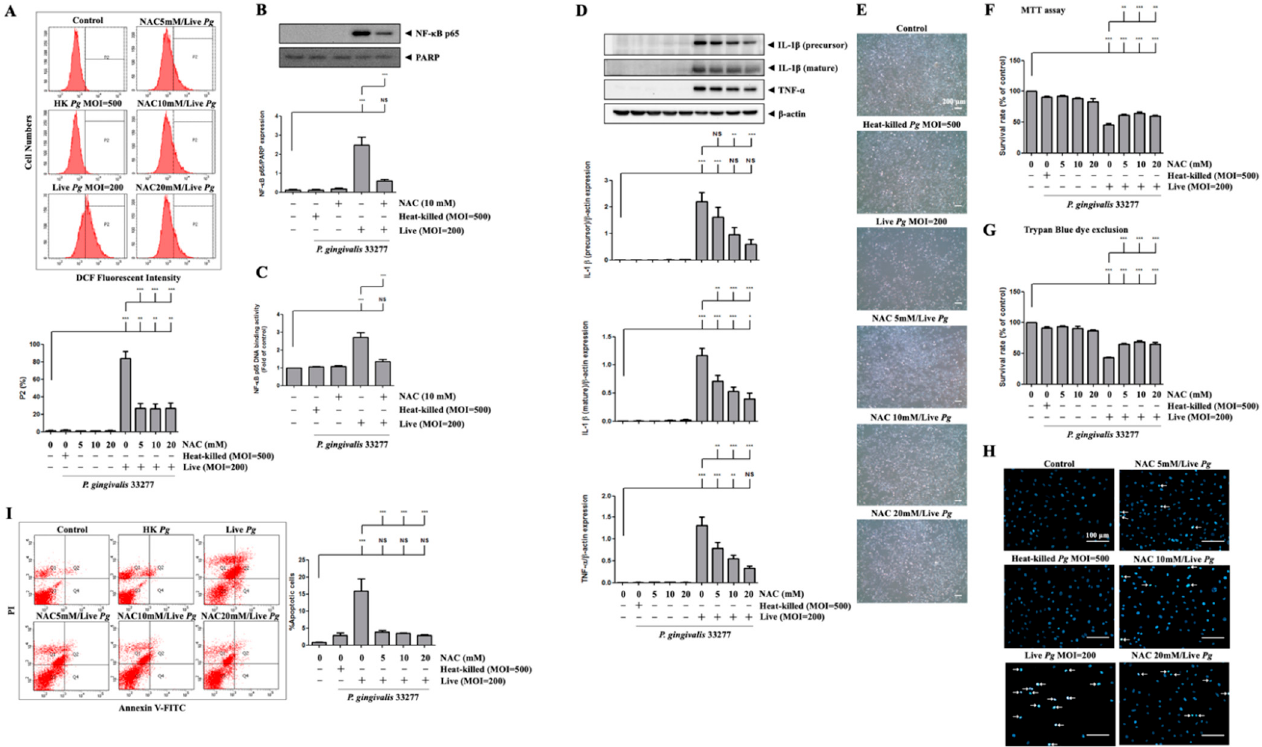
Figure 6. Inhibition of P. gingivalis-medicated ROS production inhibits NF- κ B activation, proinflammatory cytokine expression, cell apoptosis, and cell death in bEnd.3 cells. Cells are treated with various concentrations (0, 5, 10 or 20 mM) of NAC for 2 h and then infected with P. gingivalis (200 MOI) for 90 min; the ROS production is determined by DCF fluorescence using a flow cytometer ( A ). Total protein is collected, and the expression of IL-1 β (precursor), IL-1 β (mature), and TNF- α are determined by Western blotting ( D ). Morphological alterations are observed under a light microscope ( E ). The cell survival rate is evaluated by MTT assay ( F ) and Trypan Blue exclusion test ( G ). The nuclear condensation is performed by DAPI staining and viewed with a fluorescence microscope ( H ). Apoptotic cells are determined by Annexin V/PI staining and quantitated by a flow cytometer ( I ). Cells were treated with NAC (10 mM) and infected with P. gingivalis , the nuclear NF- κ B p65 and PARP protein expression are determined by Western blot analysis ( B ), and transcriptional factor binding activity is determined by NF- κ B p65 DNA-binding activity ( C ). Data are presented as mean values ± SEM ( n = 4). Significant differences of the control group and groups with or without NAC treatment are expressed as *, p < 0.05; **, p < 0.01; ***, p < 0.001; NS, p > 0.05. Scale bars are 200 µ m in ( E ) and 100 µ m in ( H